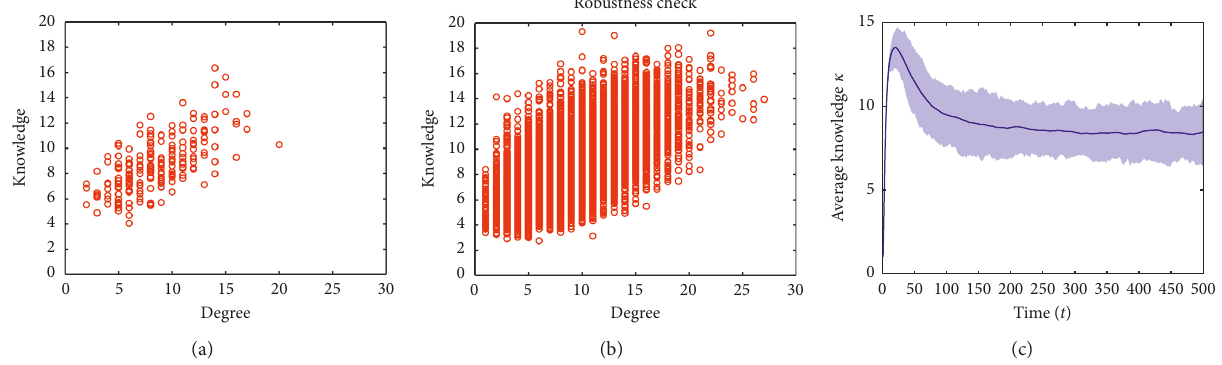
Figure 1: Evolution result when the initial R&D network structure is a random graph ( p � 0 . 1).